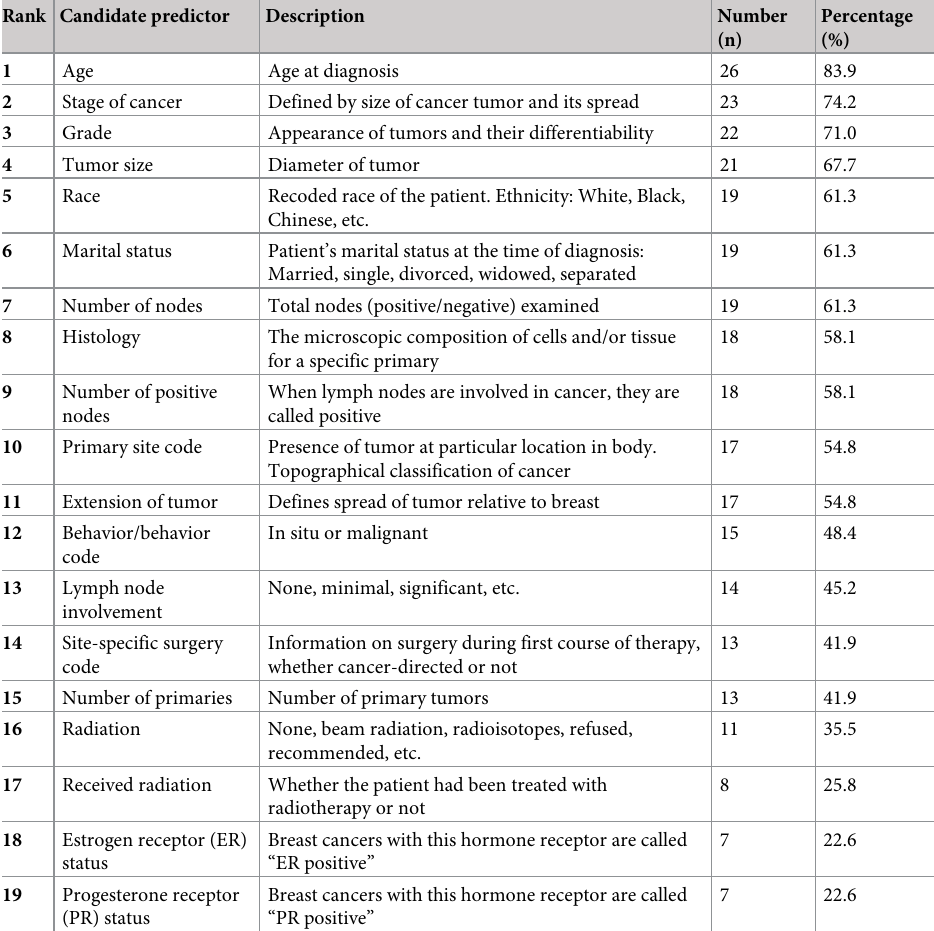
Table 4. Rank of the candidate predictors used in 31